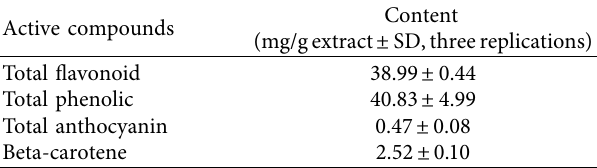
Table 1: Total active contents of the W. globosa